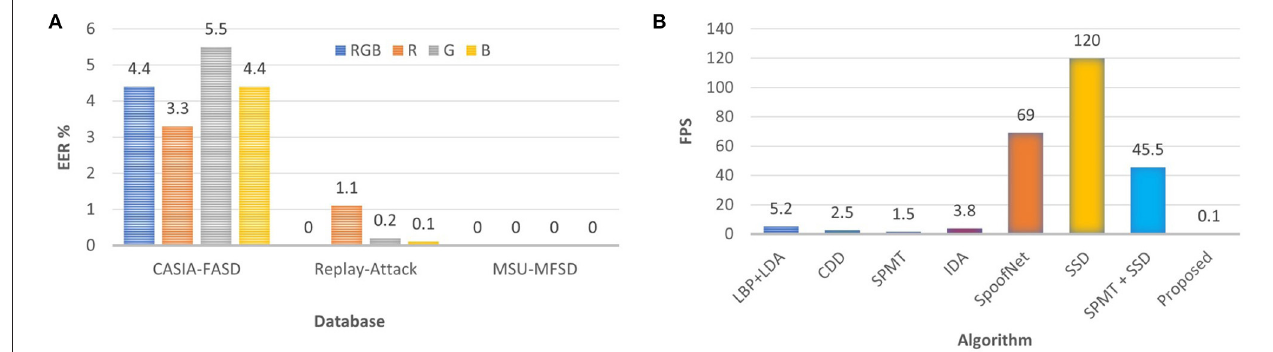
FIGURE 5 | Ablation study of the proposed PAD algorithm in terms of its performance on the individual color channel of the images. Apart from that the practicality of the proposed algorithm to be deployed in resource constraint devices using computational speed. (A) Classification results with individual color channel and RGB; (B) Computational complexity of the PAD